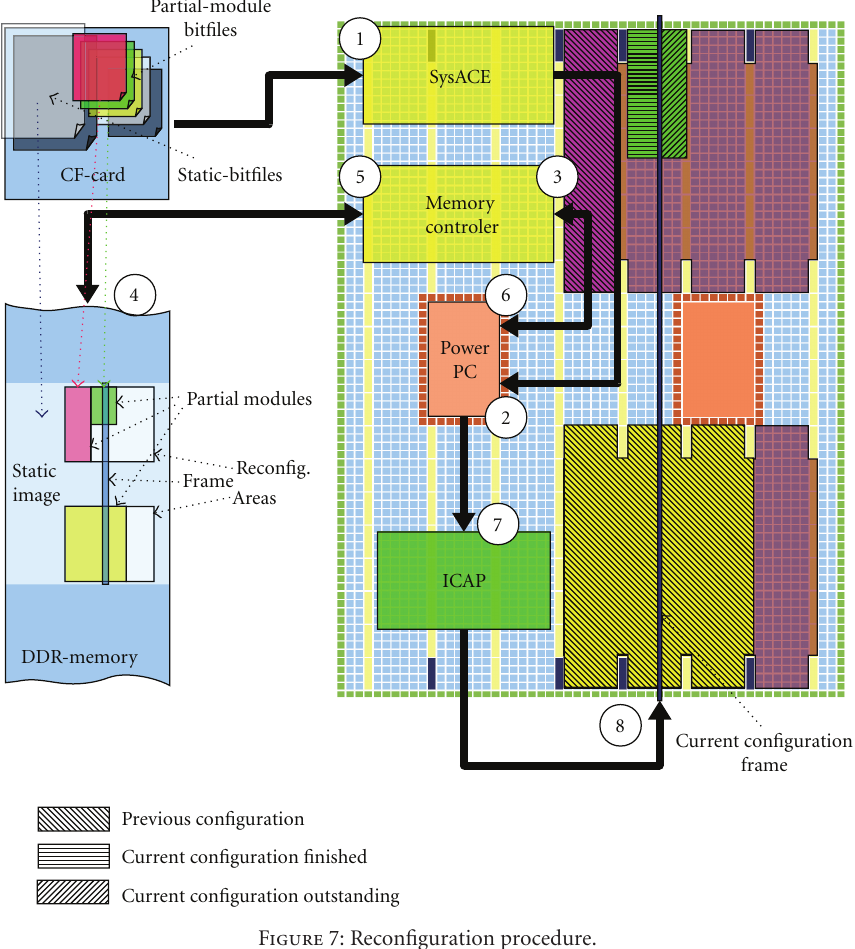
Figure 7: Reconfiguration